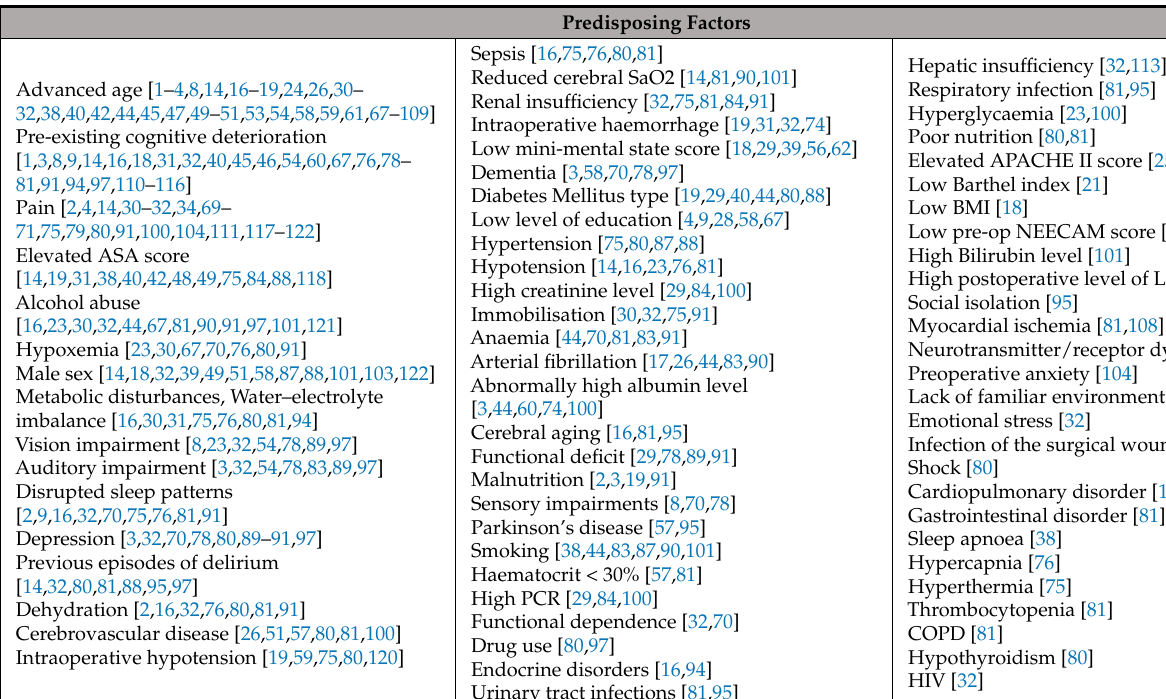
Table 1. Predisposing